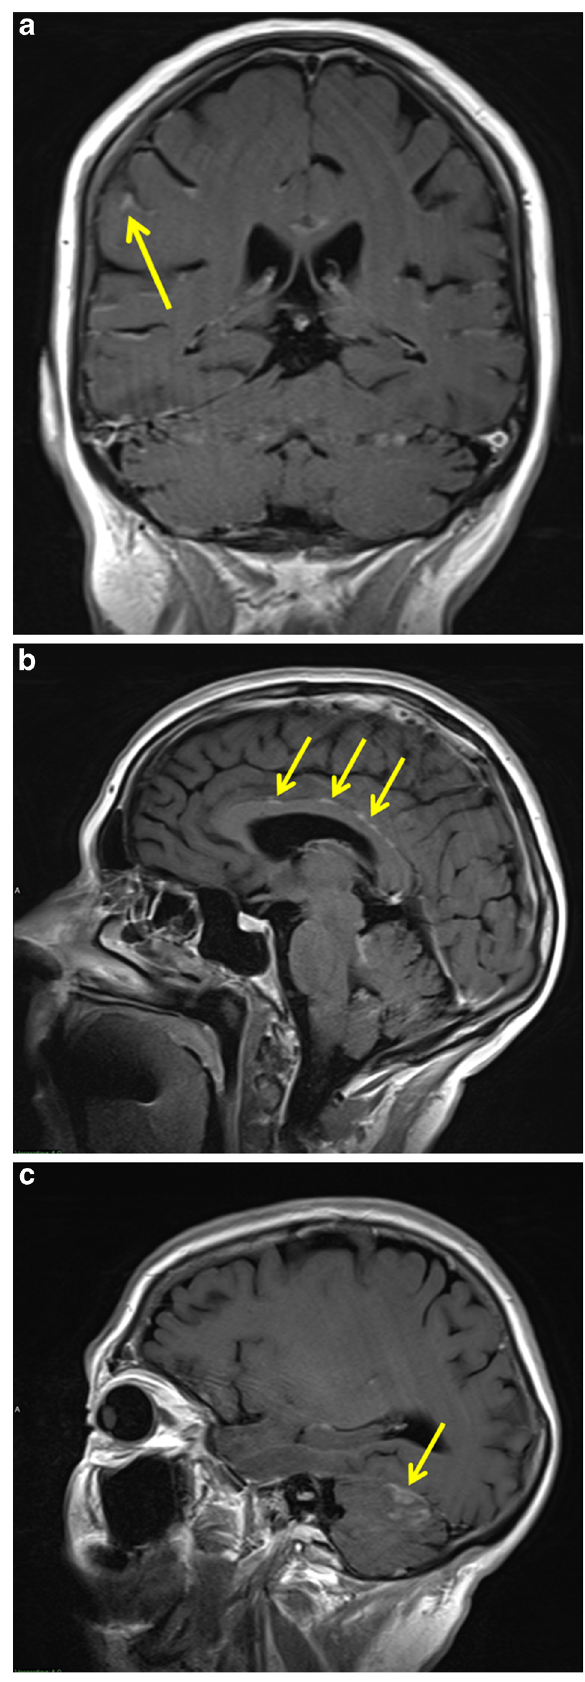
Fig. 9 Carcinomatous meningitis in a 67-year-old woman with stage IV non-small cell lung cancer. Coronal ( a ) and sagittal ( b , c ) T1-weighted MR images after intravenous gadolinium contrast administration demonstrate diffuse, nodular leptomeningeal enhancement involving both cerebral hemispheres, but more markedly along the tentorium and into the subarachnoid spaces between the cerebellar folia ( yellow arrows )